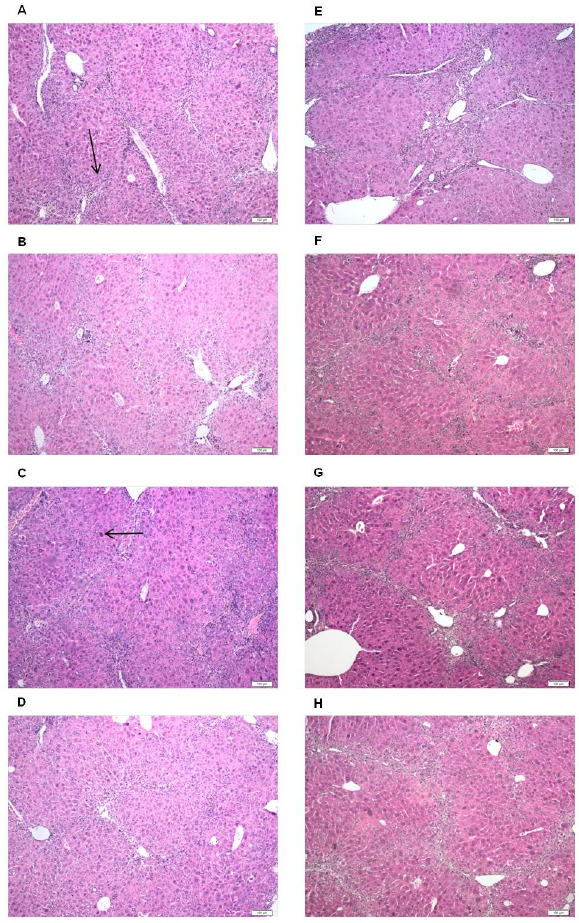
Figure 4. Effects of R. officinalis tincture on the histologic aspect of the liver: ( A , E ) the negative control groups receiving only carbon tetrachloride (1 mL/b.w.) showed inflammatory infiltrate (black arrow) and hepatocyte necrosis; the groups receiving therapy with the extract in a dose of: 5 mg/b.w., ( B , F ); 50 mg/b.w.; ( C , G ); and 500 mg/b.w. ( D , H ). Duration: ( A–D ) four weeks; ( E – H ) six weeks. Hematoxylin & Eosin stain; Bar, 100 μm.